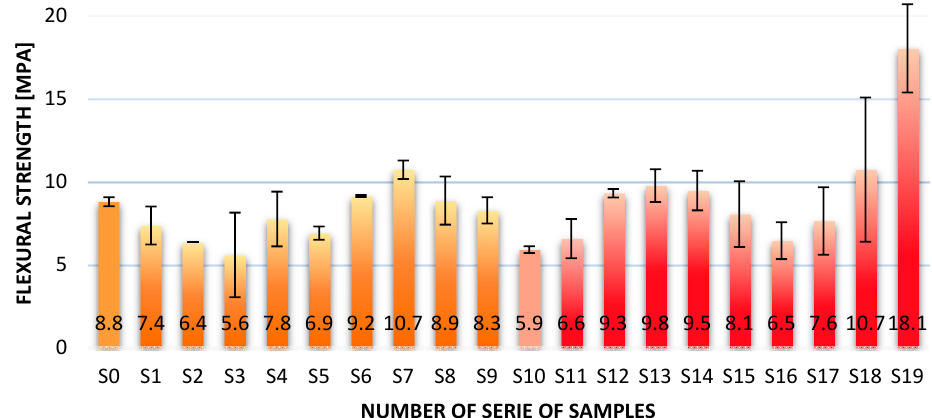
Figure 1. Density test result.